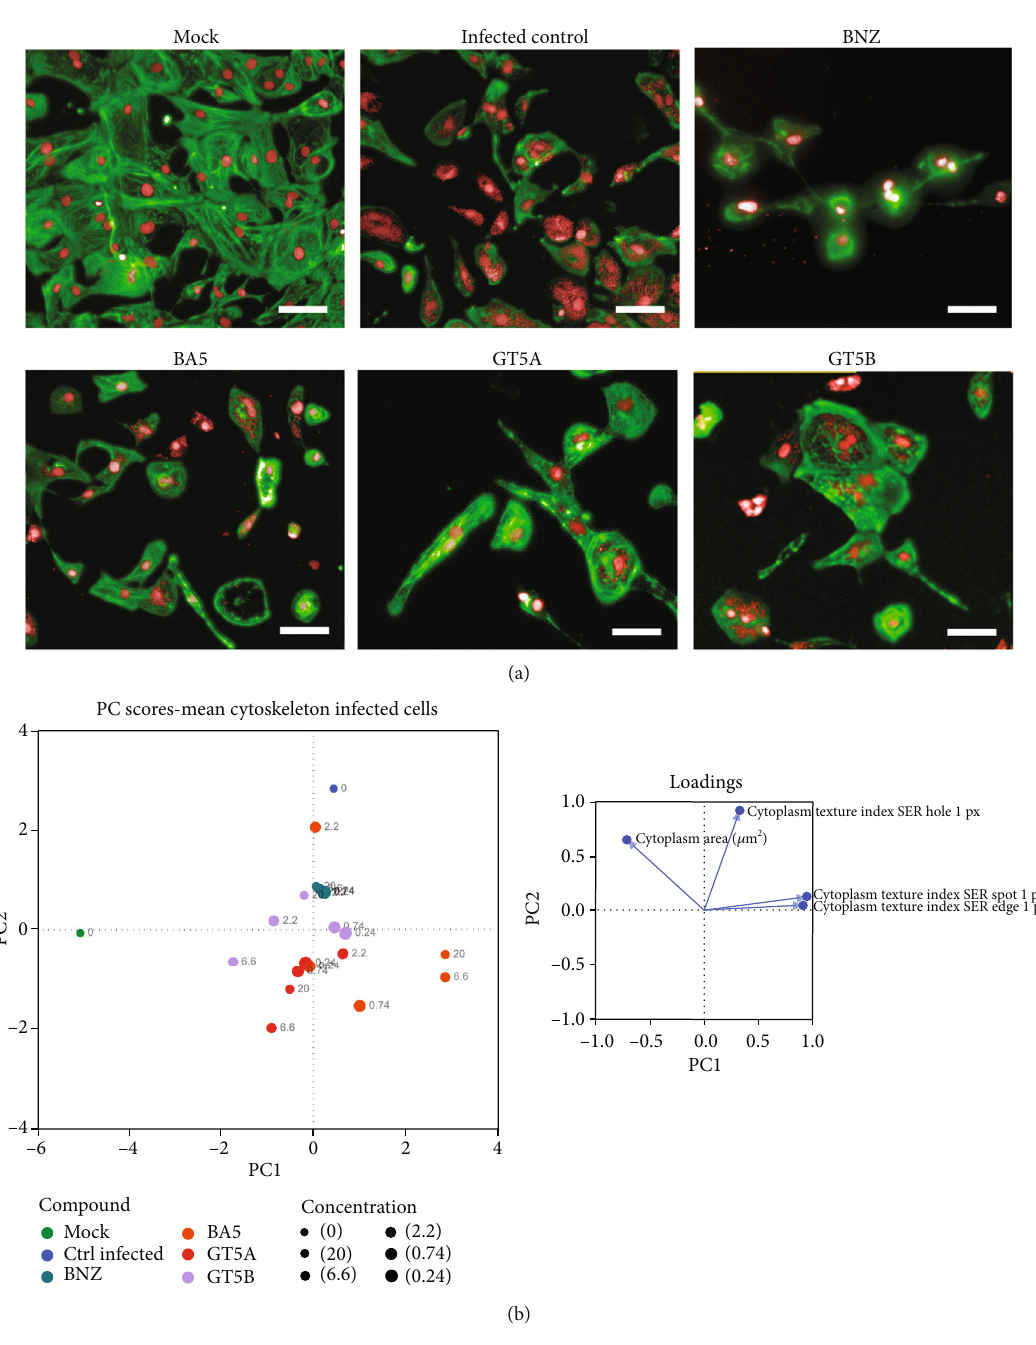
Figure 6: High-content imaging analysis of infected hiPSC-CMs treated with the compounds. (a) Representative images of hiPSC-CMs uninfected (mock) or infected with T. cruzi submitted to compound (BNZ (benznidazole), BA5, GT5A, or GT5B) testing at the concentration of 6.6 μ m. Bars = 50 μ m . (b) Principal component analysis demonstrating the e ff ects of the compounds in di ff erent concentrations to the cytoskeleton-infected hiPSC-CM